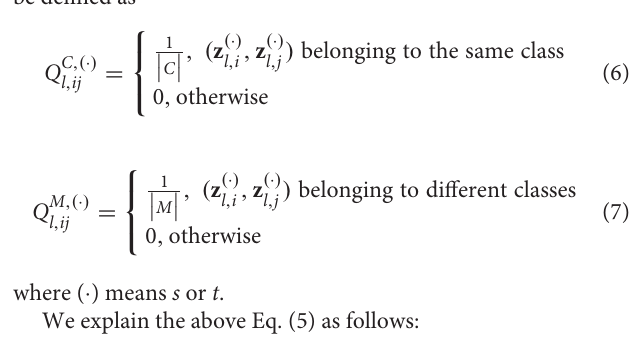
TABLE 1 | The basic information of transfer learning tasks in the experiment. Tasks Source domain Target domain T1 Normal images from the REMBRANDT dataset T2 Normal images from the REMBRANDT